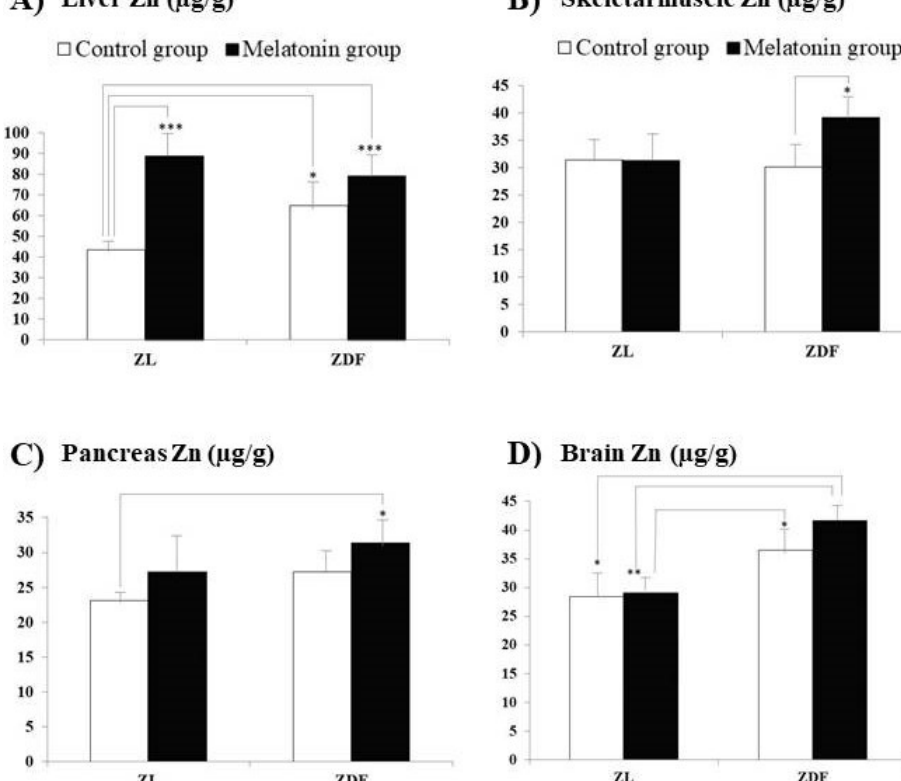
Figure 1. Influence of melatonin supplementation in Zn levels of different organ tissues in male Zücker lean and diabetic fatty rats. ( A ) Liver Zn. ( B ) Skeletal muscle Zn. ( C ) Pancreas Zn. ( D ) Brain Zn. C–ZL: Control lean rats without melatonin; M–ZL: Lean rats with melatonin; C–ZDF: Control diabetic fatty rats without melatonin; M–ZDF: Diabetic fatty rats with melatonin; ZL: Zücker lean rats; ZDF: Zücker diabetic fatty rats. Values are means ± SEM ( n = 10) of ratios of Zn levels. * p < 0.05; ** p < 0.01; *** p < 0.001 (Tukey post hoc test).